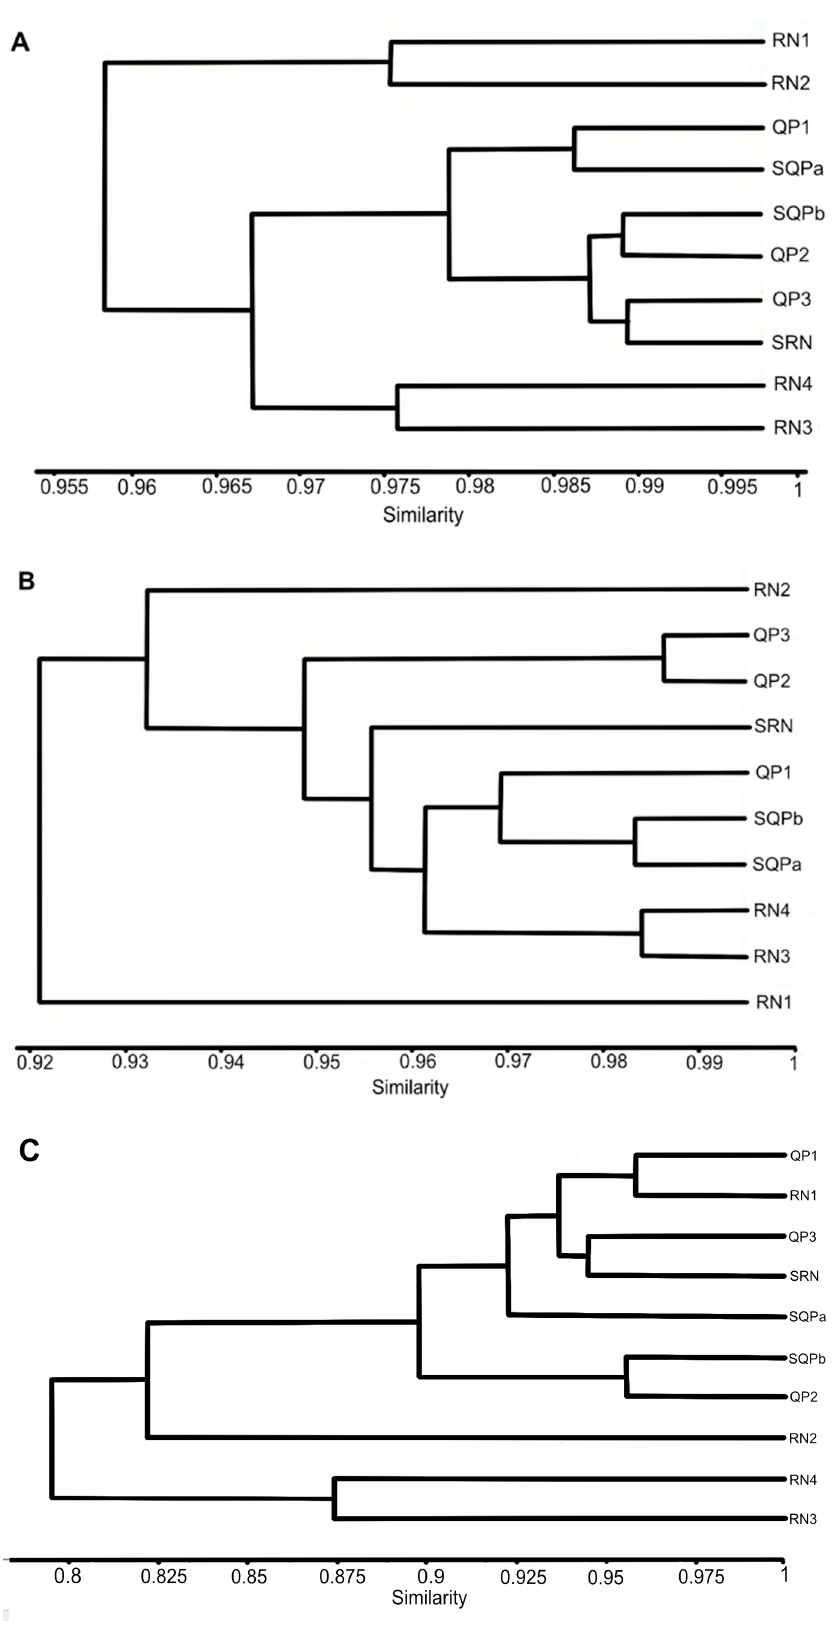
Figure 7. CLM dendrogram of the total amount of species collected ( A ) when the SD species were removed from the analysis ( B ) and the SD species by their own ( C ) in the studied forest sites (NNP, Podlaskie, North-East Poland).